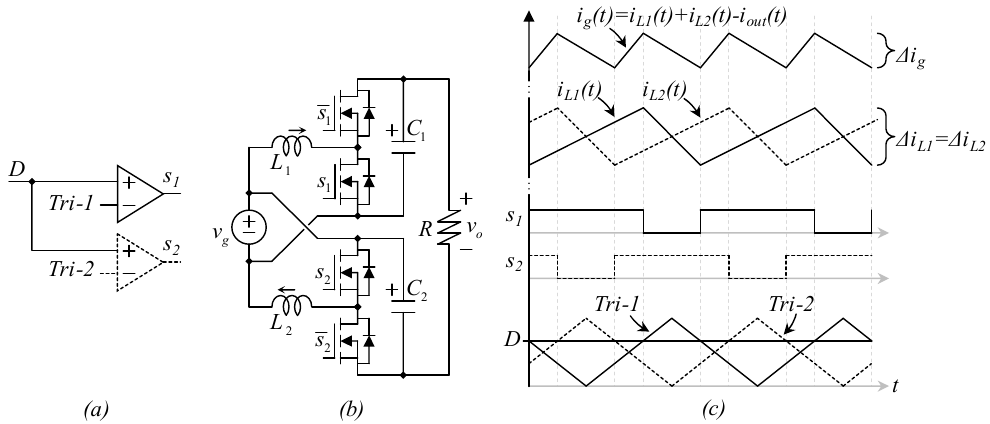
Figure 6. The double dual boost converter (DDBC) ( a ) pulse width modulation (PWM) block diagram, ( b ) circuit schematic, and ( c ) important waveforms of the PWM strategy and the circuit operation.